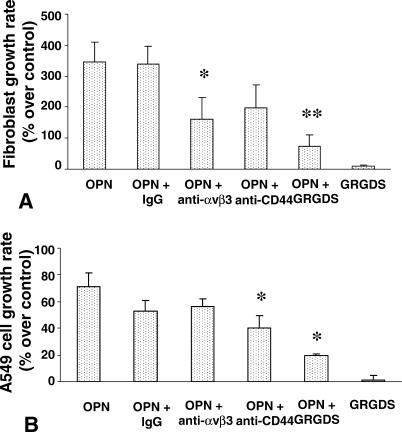
Effect of Osteopontin on Fibroblasts and Epithelial Cell ProliferationHuman normal lung fibroblasts (A) and A549 epithelial cells (B) were grown in Ham's F-12 medium with 0.1% FBS and stimulated with 2 μg/ml osteopontin. In parallel, osteopontin-stimulated cells were treated with anti-αvβ3, anti-CD44, and GRGDS. Each bar represents the mean ± SD of three experiments performed in triplicate; *p < 0.05; **p < 0.01.OPN, osteopontin